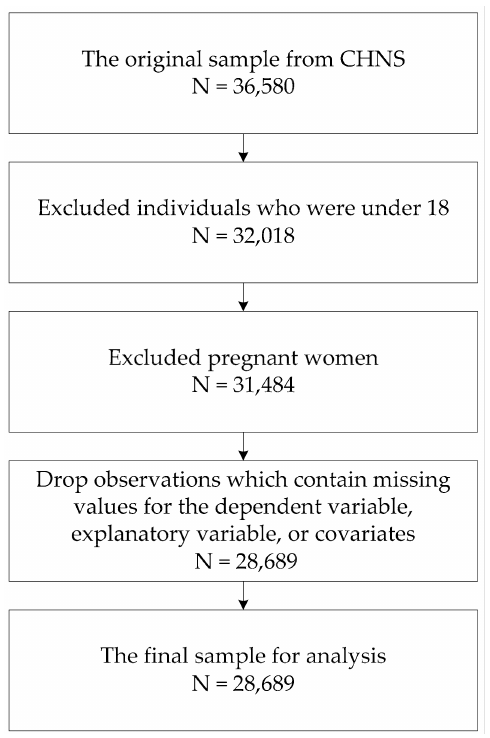
Figure A1. The sample selection